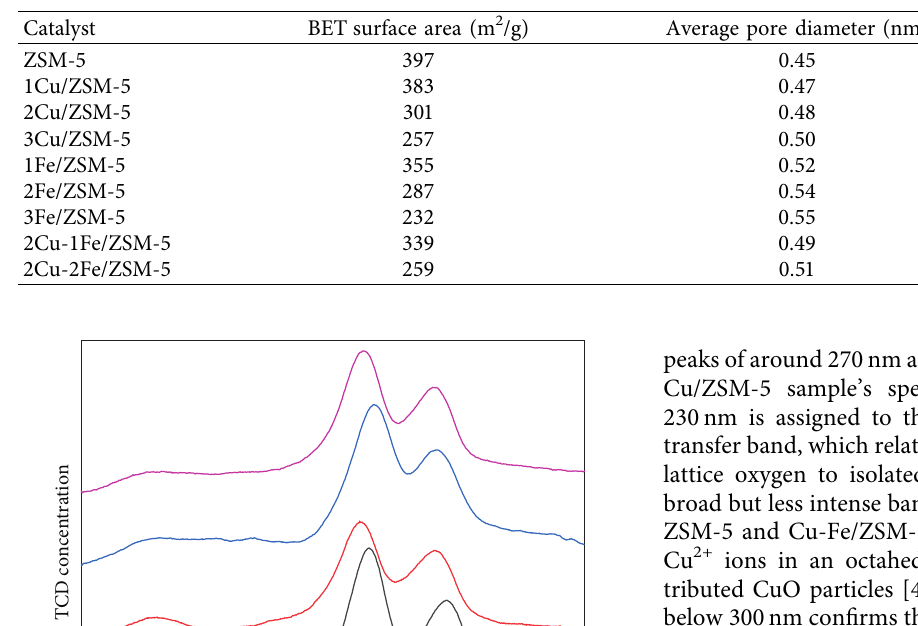
Table 2: The main textural properties of all catalysts.